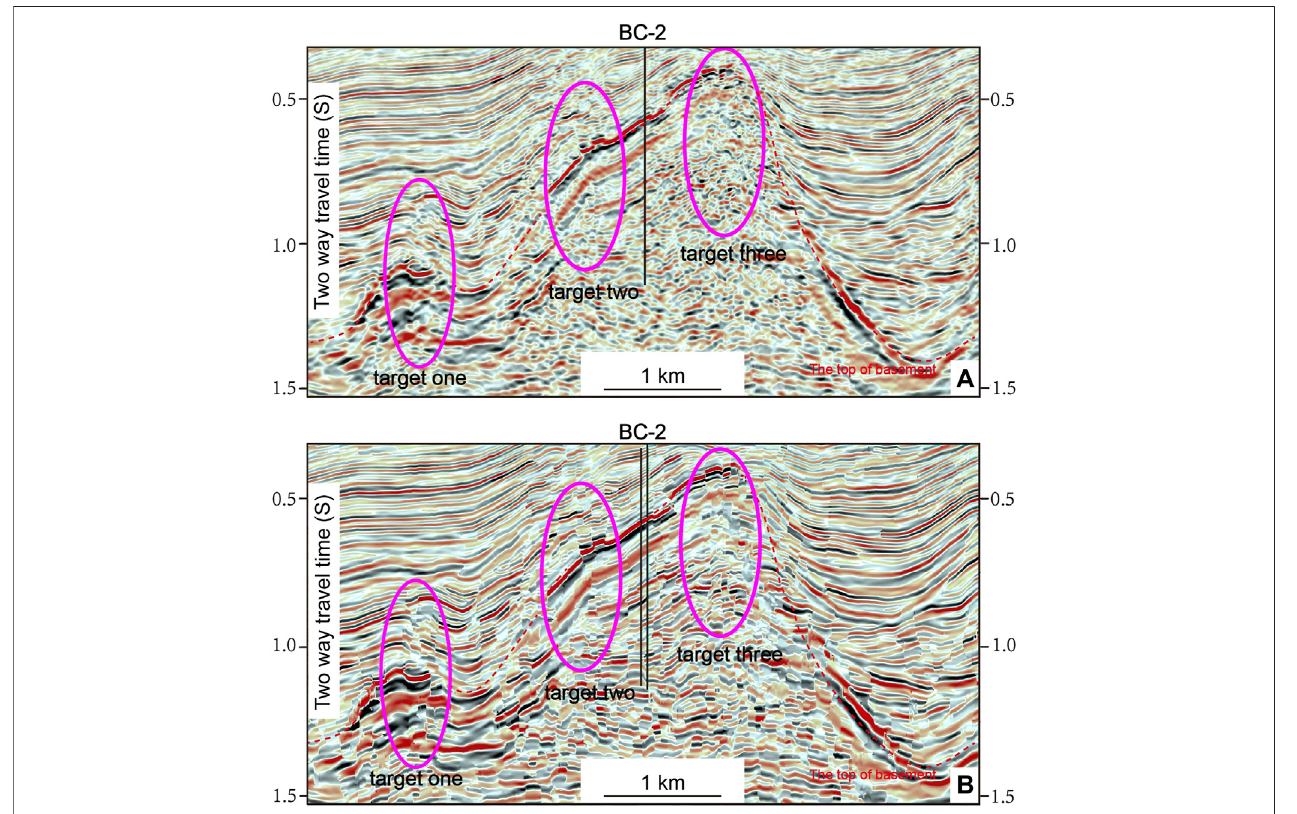
FIGURE 5 | Seismic pro fi le before and after structure-oriented fi ltering. (A) Original seismic pro fi le; (B) Seismic pro fi le after structure-oriented fi ltering.